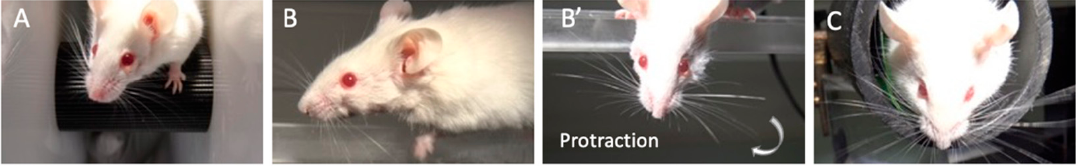
Table 2. Videoscoring of whisker movement